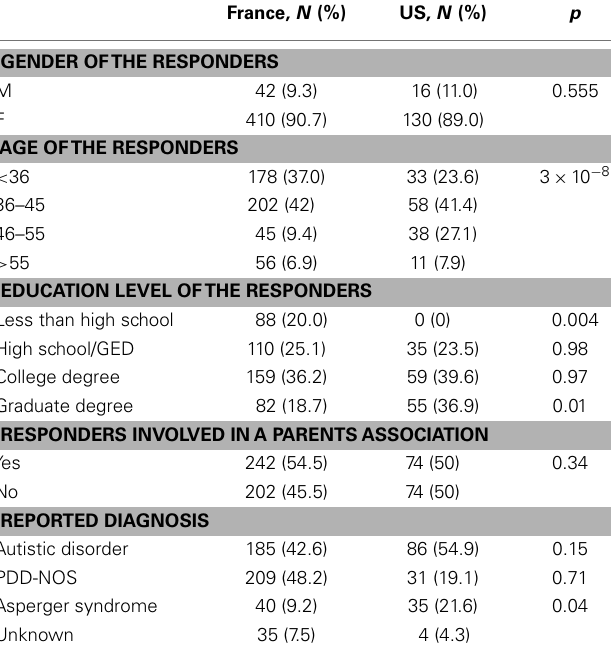
Table 2 | Sample characteristics.